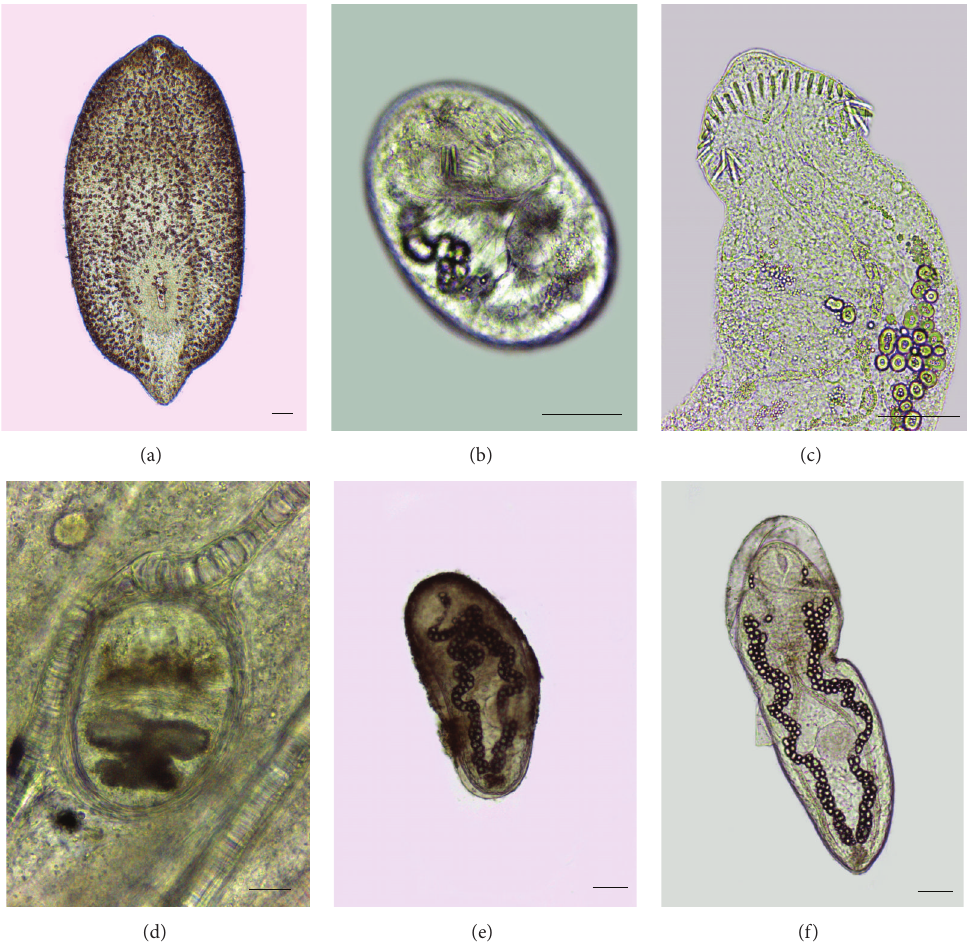
Figure 1: Metacercariae found in naturally infected specimens of Nile tilapia ( Oreochromis niloticus ) collected in Pampulha reservoir, Belo Horizonte, Minas Gerais, Brazil. (a) Austrodiplostomum compactum recovered in the eyes; (b) encysted Drepanocephalus sp. found in oral cavity; (c) mechanically excysted specimen of Drepanocephalus sp. and detail of spines of cephalic collar; (d) Centrocestus formosanus found encysted in the gills; (e) Ribeiroia sp. recovered encysted in oral cavity; and (f) mechanically excysted specimen of Ribeiroia sp. All images obtained from unstained wet mount preparation. Scale bar = 50 𝜇